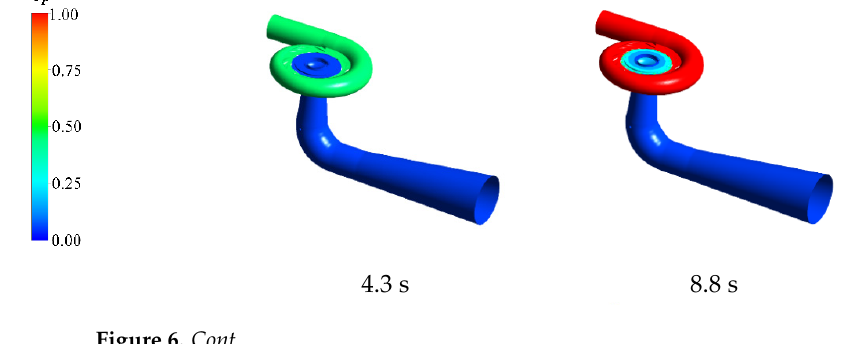
197.3s Figure 6. Pressure distribution of the PT flow channel during turbine start-up. It can be seen from Figure 7 that from t = 0 s to t = 13.2 s during turbine start-up as the opening of the guide vanes increases, the flow increases, and the pressure in the area between the stay vanes and the guide vanes also increases. The high-pressure area at the trailing edge of the guide vanes the increases, while the pressure on the runner blade sur- face also increases. From t = 18.7 s, the high-pressure area on the trailing edges of the guide vanes reduces, and the low-pressure area appears on the blade outlet edge. When the ro- tating speed of the runner reaches the rated speed, the guide vane will close a little to